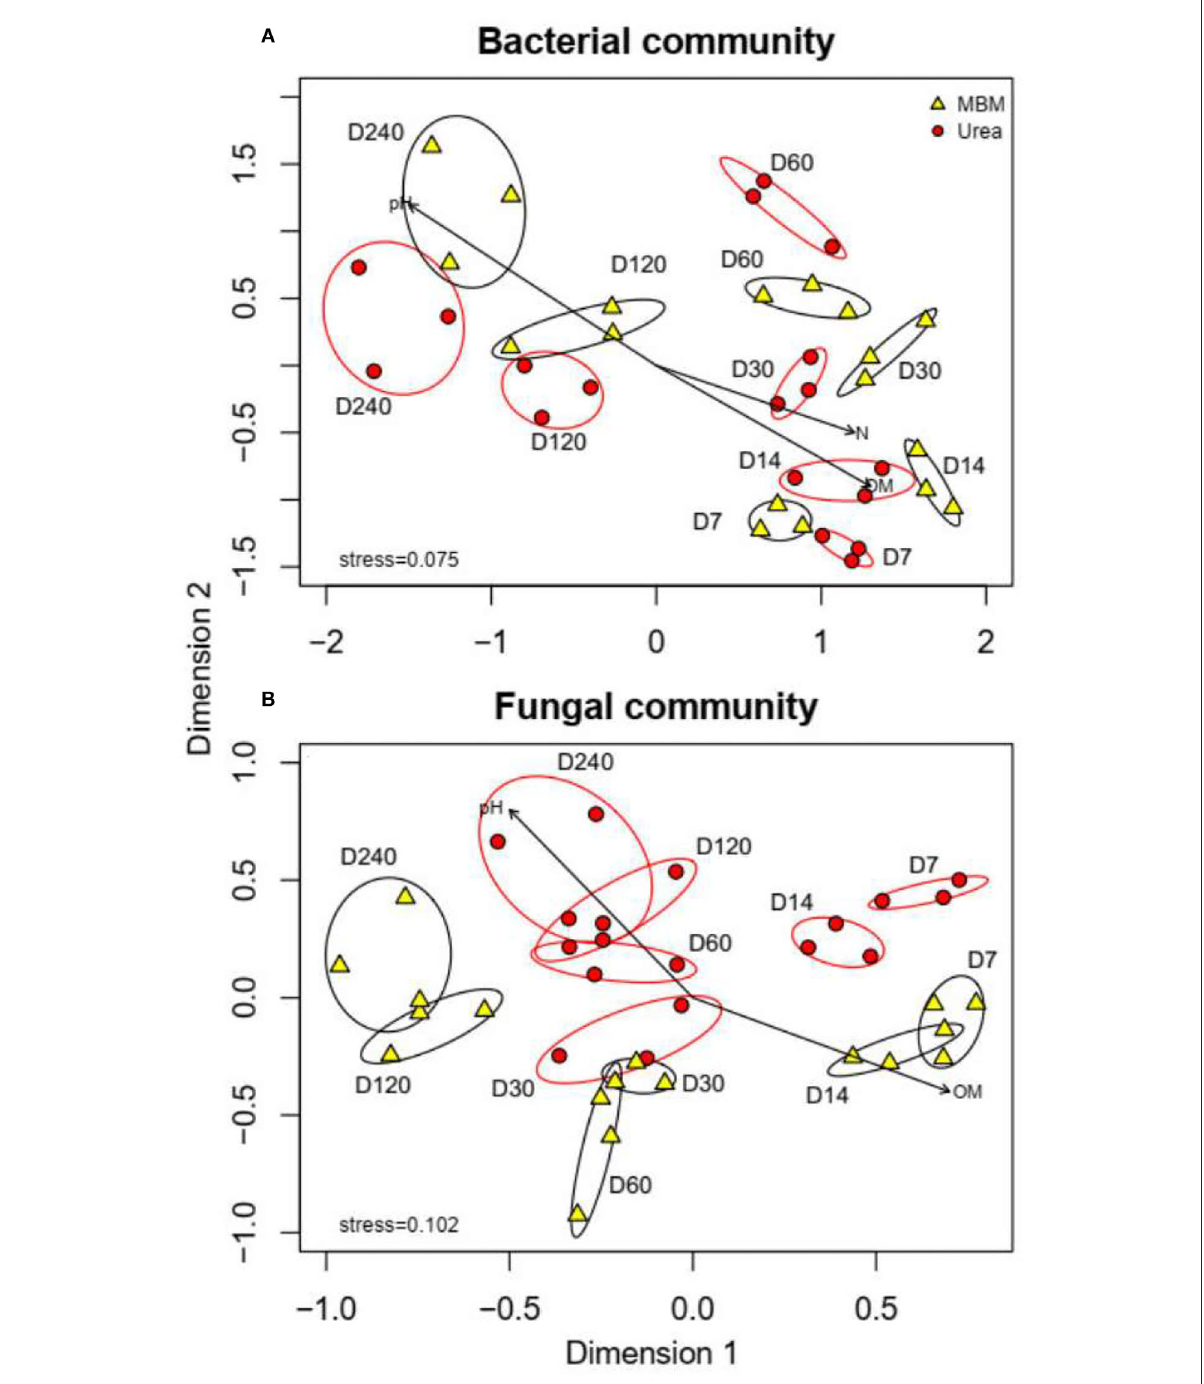
FIGURE4 NMDS plots for bacterial and fungal communities of MBM treatments and urea treatments on days 7, 14, 30, 60, 120, and 240. MBM, meat and bone meal; urea, urea treatments.